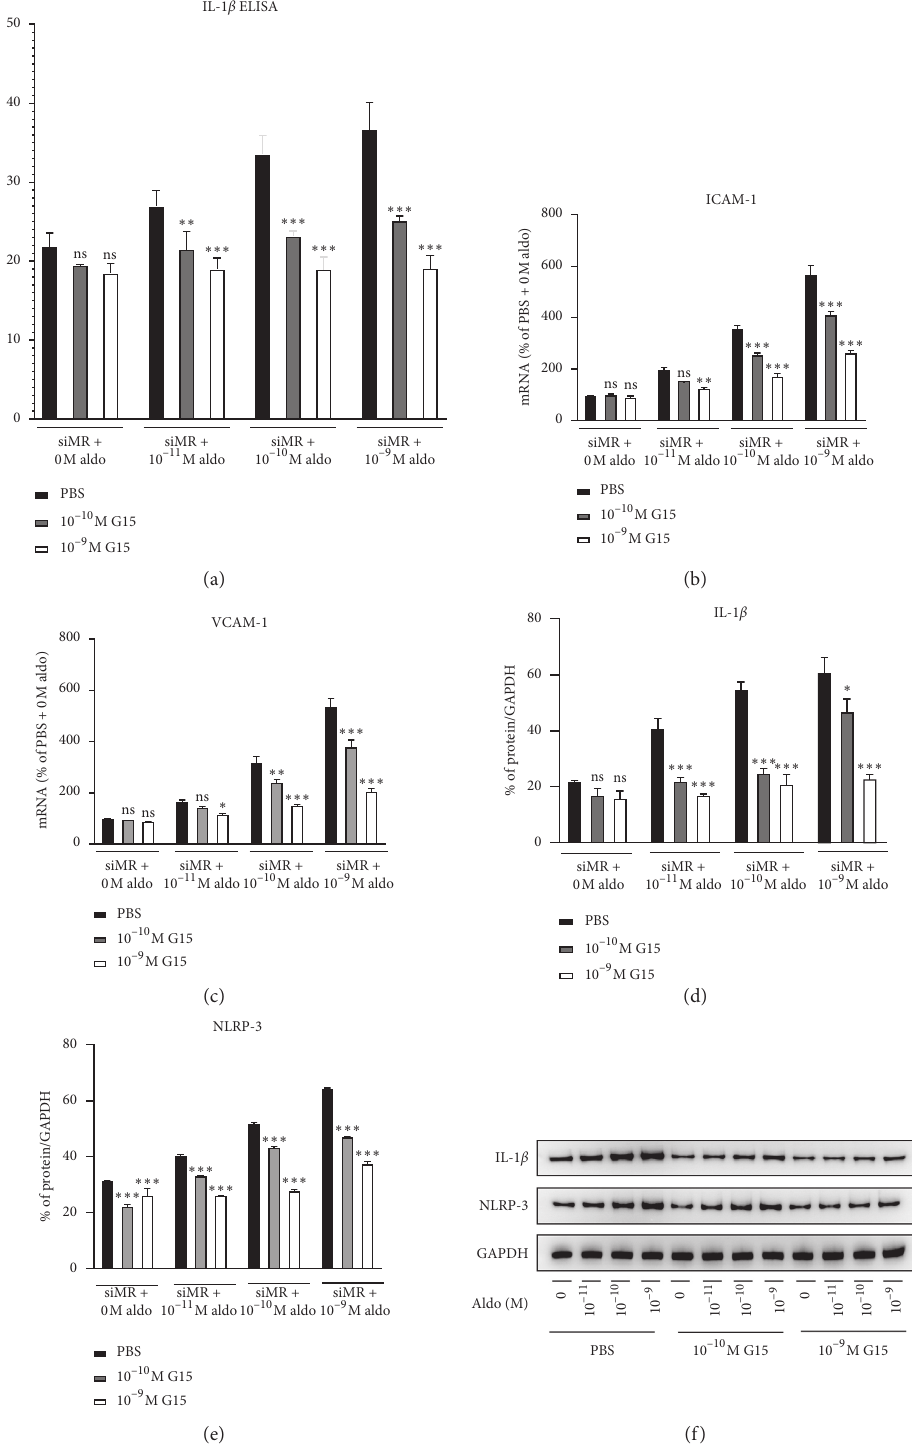
Figure 3: Inflammatory response before and after treatment with different concentrations of G15: (a) level of cell culture medium IL-1 β ; (b) ICAM-1 mRNA expression; (c) VCAM-1 mRNA expression; (d) protein level of IL-1 β from PBS to 10 − 9 M G15; (e) protein level of NLRP-3 from PBS to 10 − 9 M G15; (f) Western blot of IL-1 β and NLRP-3 from PBS to 10 − 9 M G15. SiMR: the state after MR knockdown, aldo: aldosterone. ∗ p value < 0.05 compared with PBS within the same aldosterone concentration, ∗∗ p value < 0.01 compared with PBS within the same aldosterone concentration, ∗∗∗ p value < 0.001 compared with PBS within the same aldosterone concentration. ns: nonsignificant compared with PBS within the same aldosterone